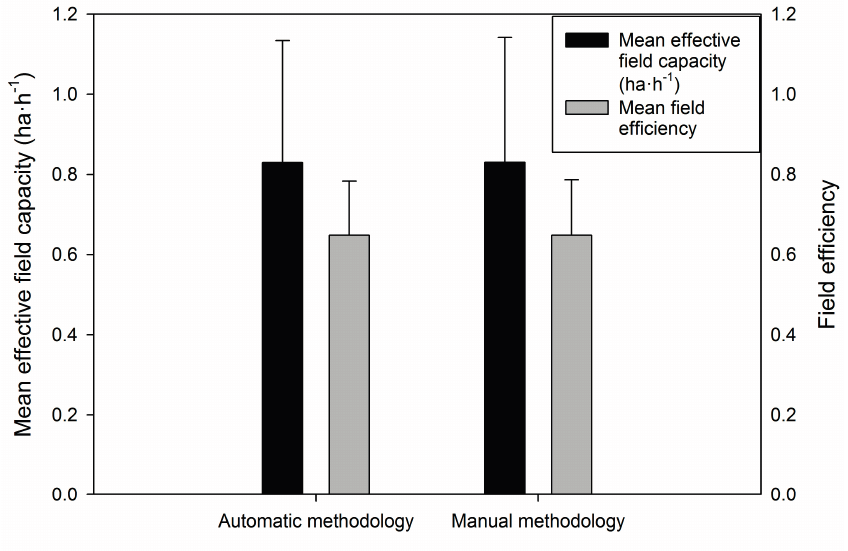
Figure 3. Effective field capacity and field efficiency calculated using automatic and manual methodologies. Different letters show significant differences between groups according to Student’s t -test ( p <